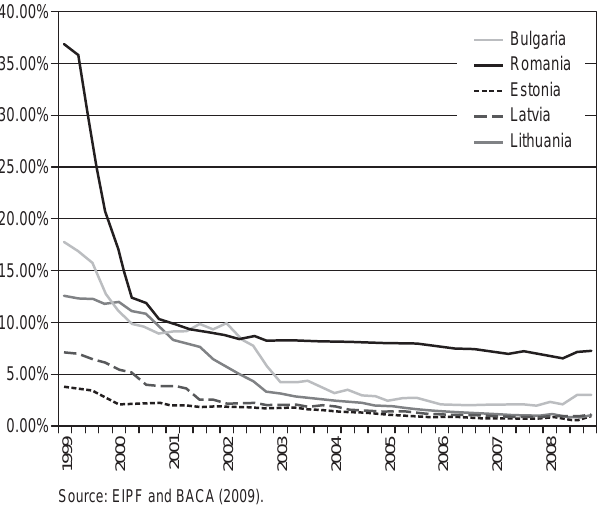
Fig. 1. The NPL ratio dynamics in the Baltic